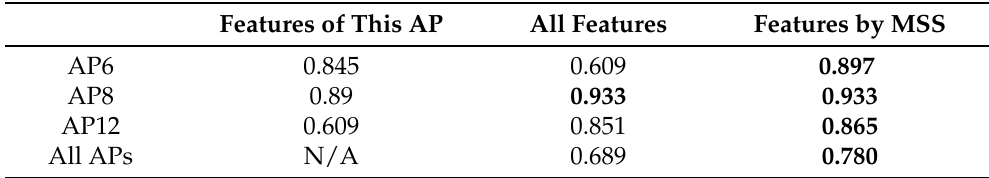
Table 4. The Macro F1 score performance of all APs and individual AP LOS identification using different sets of features.